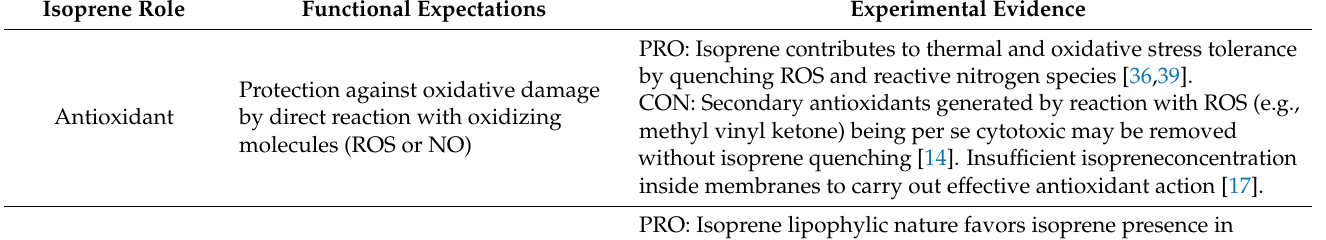
Table 2. Summary of all the biological roles that have been proposed for isoprene, with associated functions that are expected to be implemented, and experimental evidence in favor (PRO) or against (CON) the alleged role. Isoprene